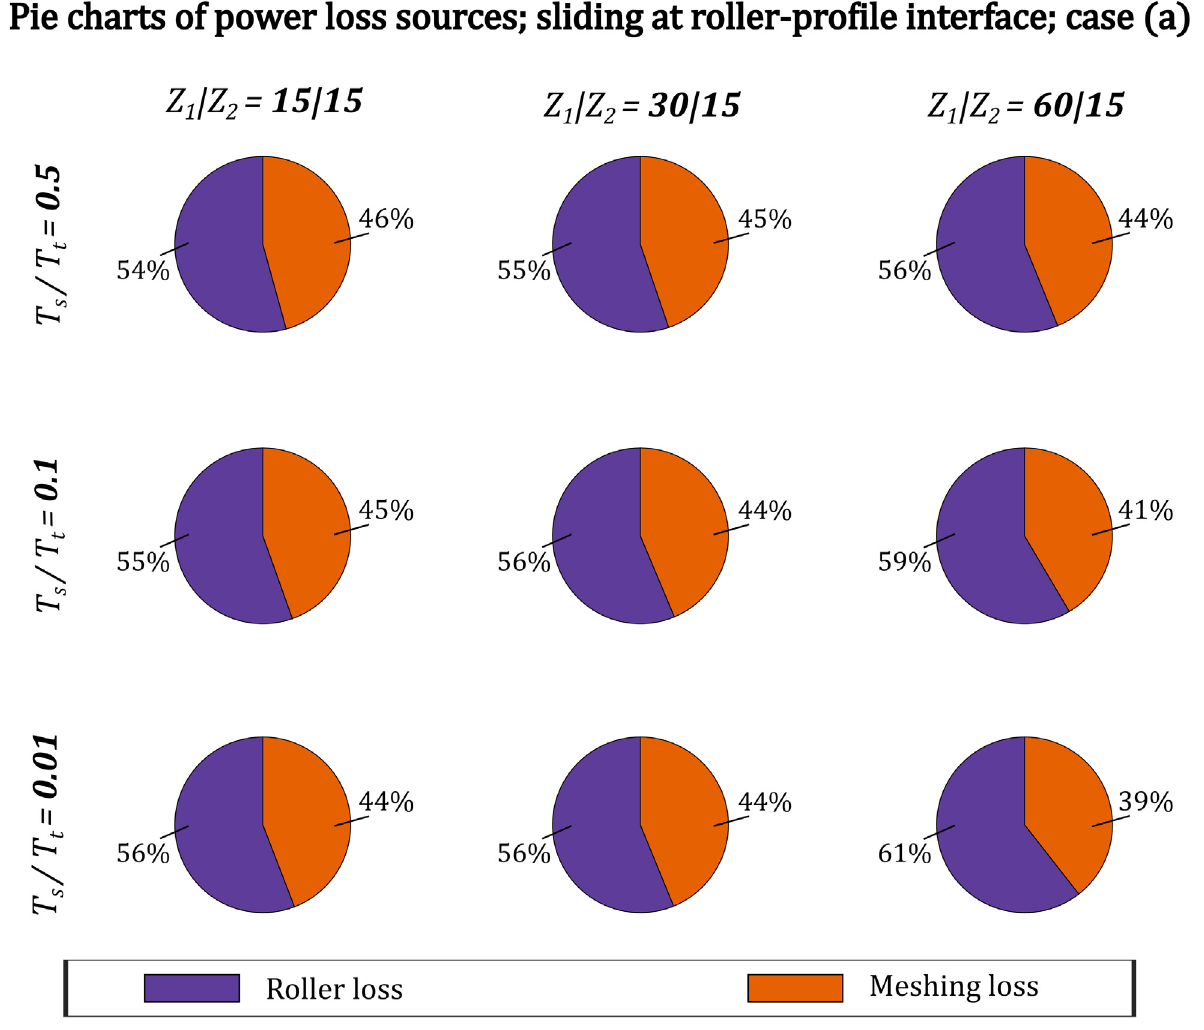
Fig. C1. Pie charts for case